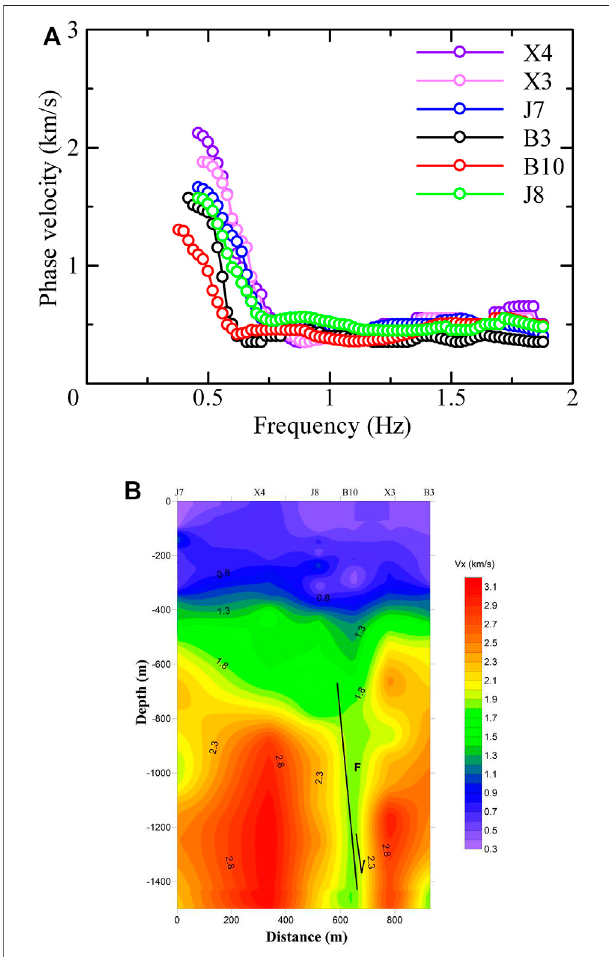
FIGURE5| Dispersioncurveofallthesurveypoints (A) and2Dapparent S-wave velocity section to identify the buried channel for heat fl ow (B) .